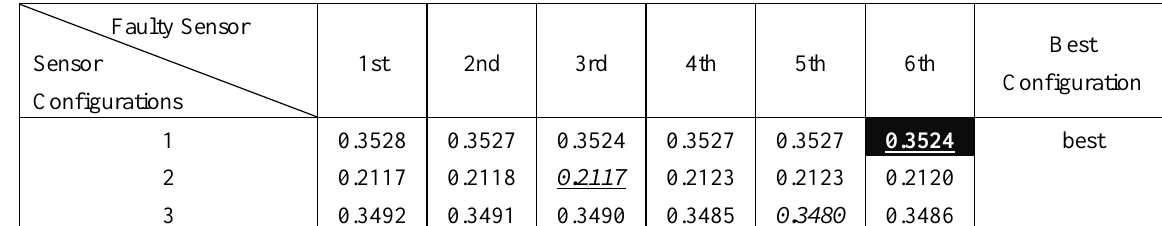
Table 9 . PCI for each faulty sensor with